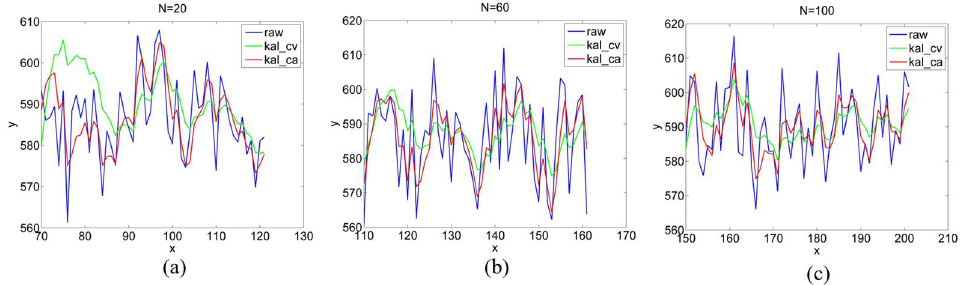
Figure 14. y-values of P8 with different numbers of motion images. ( a – c ) are y-values of P8 with 20, 60 and 100 motion images between P6 and P8.